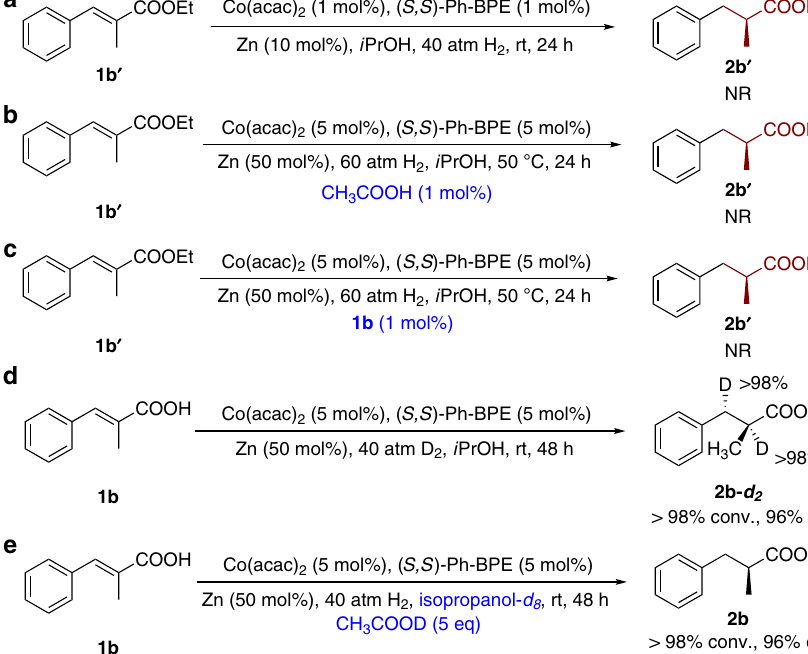
Fig. 6 Control experiments and mechanistic investigations. a Hydrogenation of ester 1b ′ under standard conditions. b Hydrogenation of ester 1b ′ in the presence of catalytic amount of CH 3 COOH. c Reaction of ester 1b ′ in the presence of catalytic amount of 1b . d Deuterium-labeling experiment. e Hydrogenation of 1b in isopropanol- d 8 with CH 3 COOD as